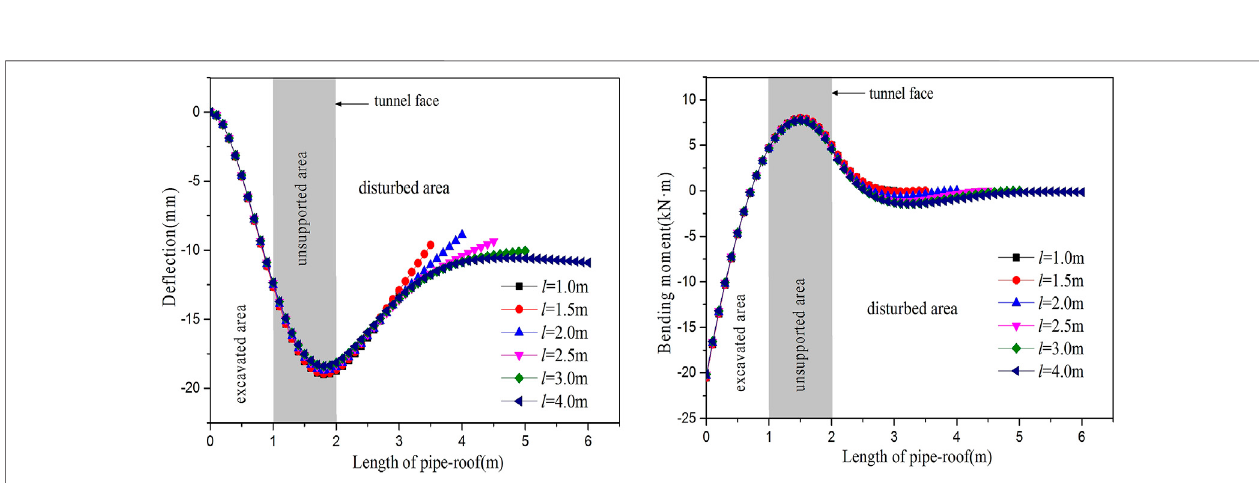
FIGURE 15 | The de fl ection and bending moment curves of the pipe-roof with different remaining lengths.